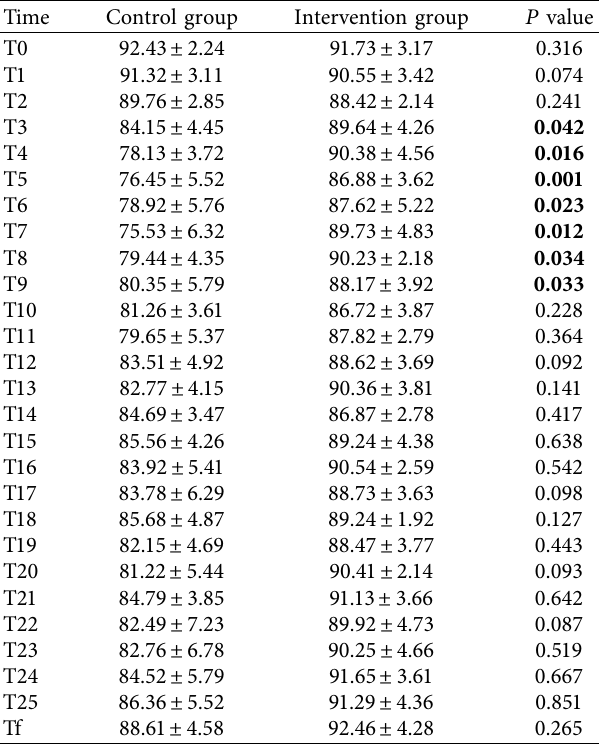
Table 2: Mean arterial blood pressure variation in both